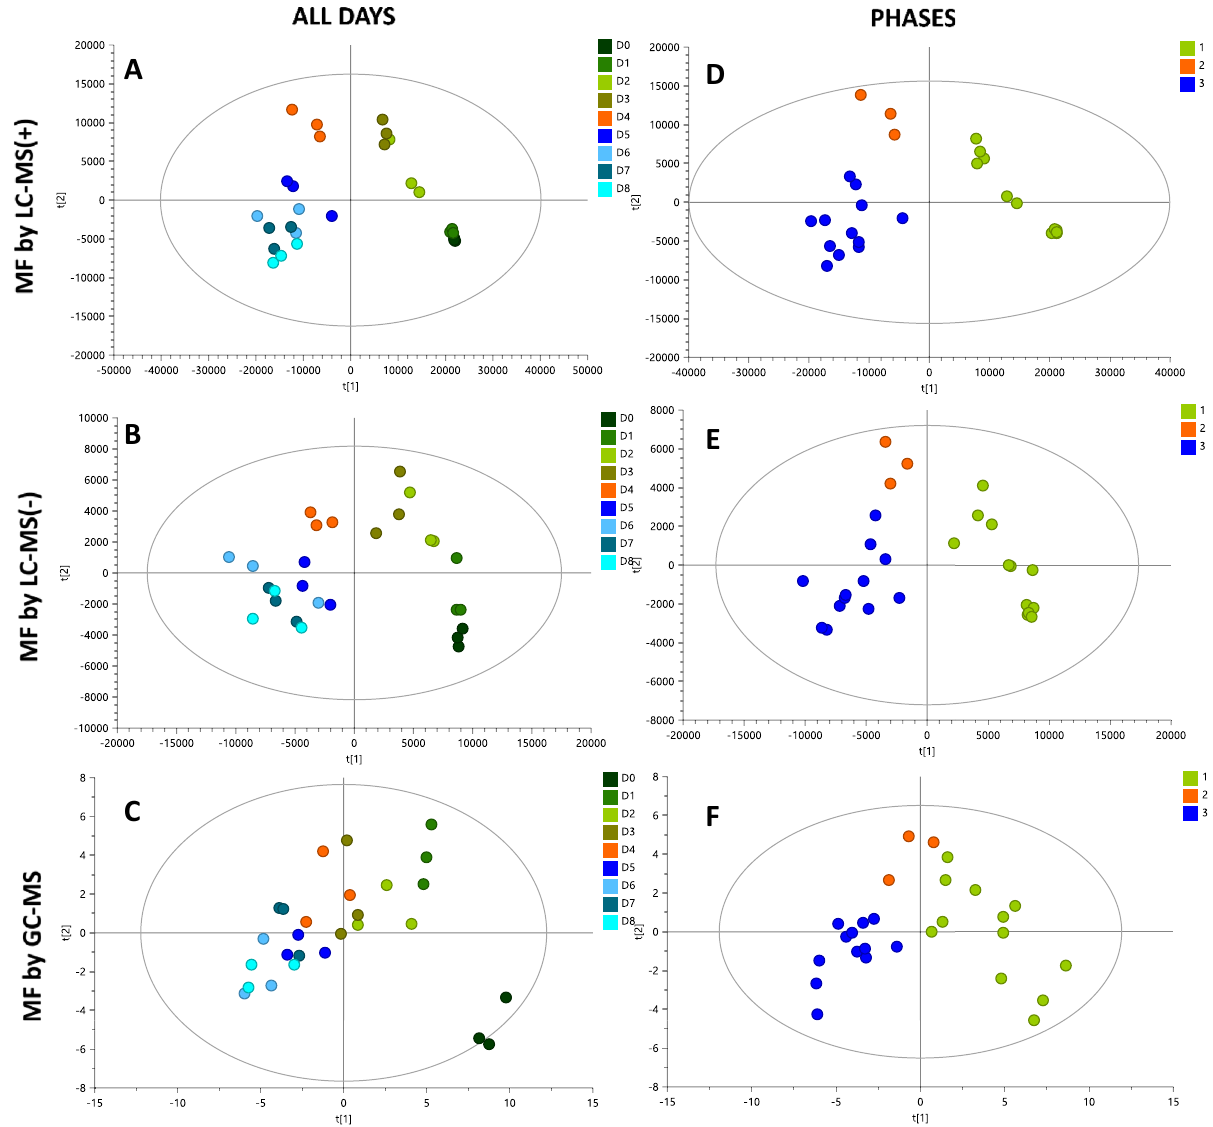
Figure 3. PLS-DA models for all cocoa fermentation samples and the proposed metabolic phases. ALL DAYS: ( A ) MF by LC–MS( +): R 2 (cum): 0.838, Q 2 (cum): 0.137, cv-anova: 0.995; ( B ) MF by LC–MS(-): R 2 (cum): 0.696, Q 2 (cum): 0.083, cv-anova: 0.993; ( C ) MF by GC–MS: R 2 (cum): 0.442, Q 2 (cum): 0.084, cv-anova: 0.951. PHASES: ( D ) MF by LC–MS( +): R 2 (cum): 0.907, Q 2 (cum): 0.899, cv-anova: 6.296e−07; ( E ) MF by LC–MS(- ): R 2 (cum): 0.903, Q 2 (cum): 0.804, cv-anova: 0.00053; ( F ) MF by GC–MS: R 2 (cum): 0.415, Q 2 (cum): 0.45, cv-anova: